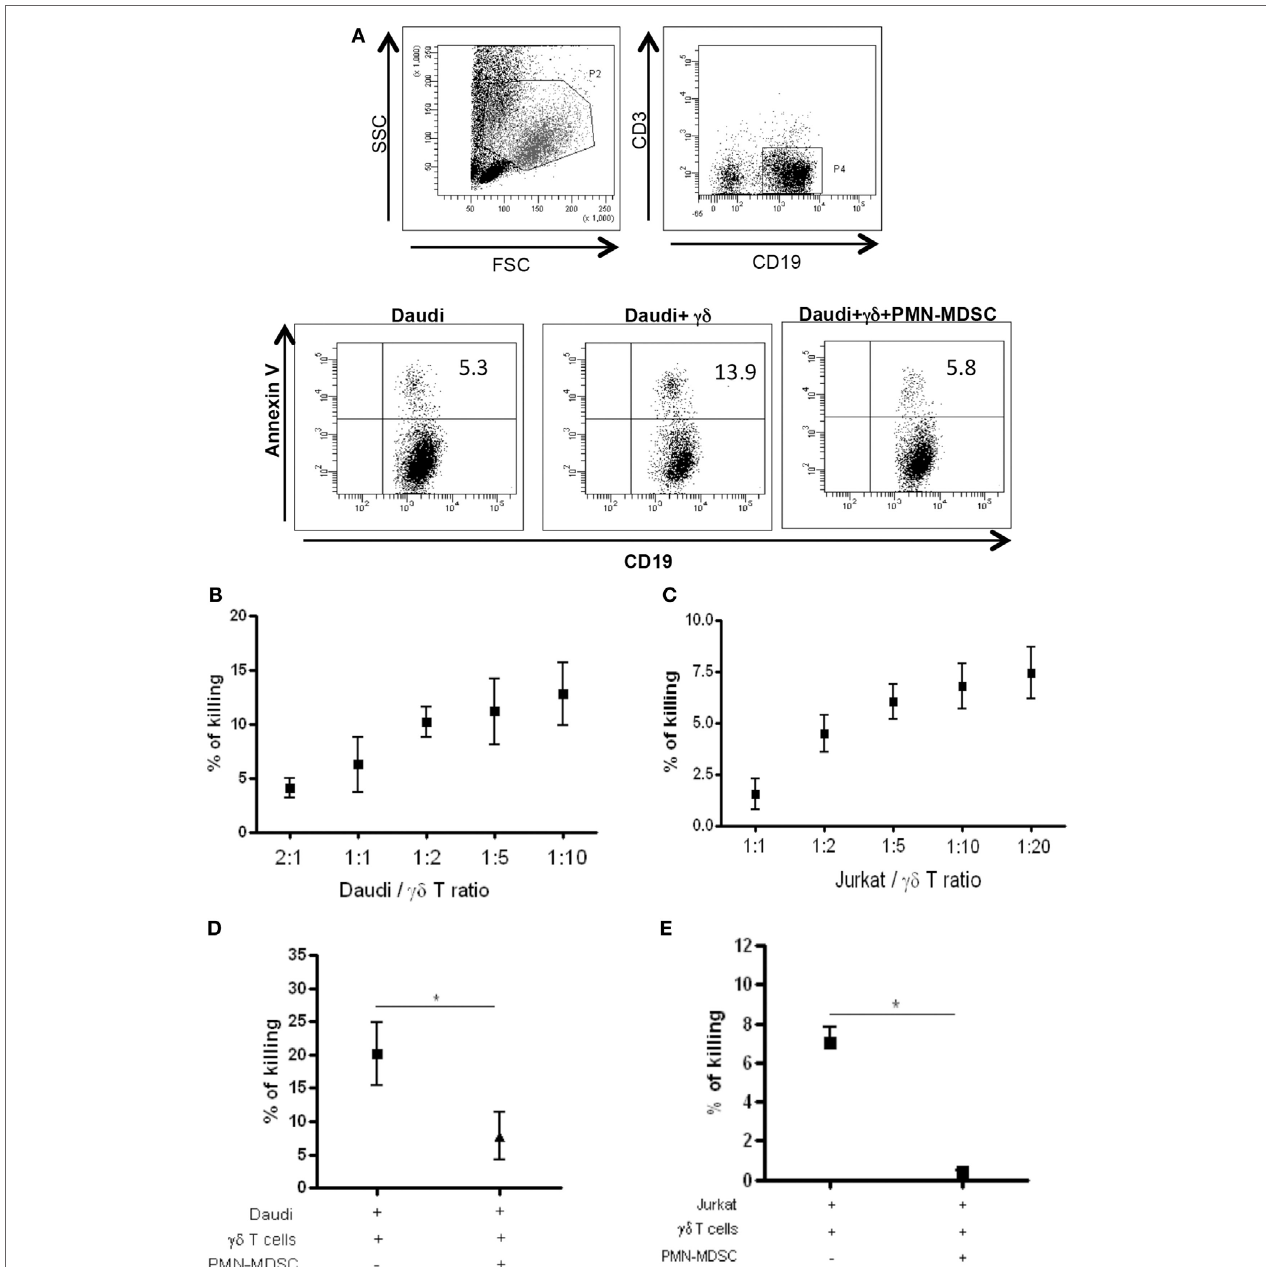
FigUre 4 | PMN-myeloid-derived suppressor cells (MDSC) inhibit Daudi and Jurkat cells killing by V δ 2 T cells . Daudi and Jurkat cells were cultured with purified γδ T cells and PMN-MDSC, and γδ T cells induced apoptosis were evaluated by measuring annexin V ligation to apoptotic cells. (a) Representative dot plots showing gating strategy and Annexin V + Daudi cells in the indicated conditions (1:2:2 ratio). (B) and (c) Titration of Daudi and Jurkat cells/ γδ T cells ratio by measuring the percentage of killing of target cells by flowcytometry. Results are shown as mean + SEM of three independent experiments. (D) Percentage of killing of Daudi cells by γδ T cells in the presence of PMN-MDSC (1:2:2 ratio). Results are shown as Mean + SEM of four independent experiments. (e) Percentage of killing of Jurkat cells by γδ T cells in the presence of PMN-MDC (1:5:5 ratio). Results are shown as Mean + SEM of three independent experiments (* p <